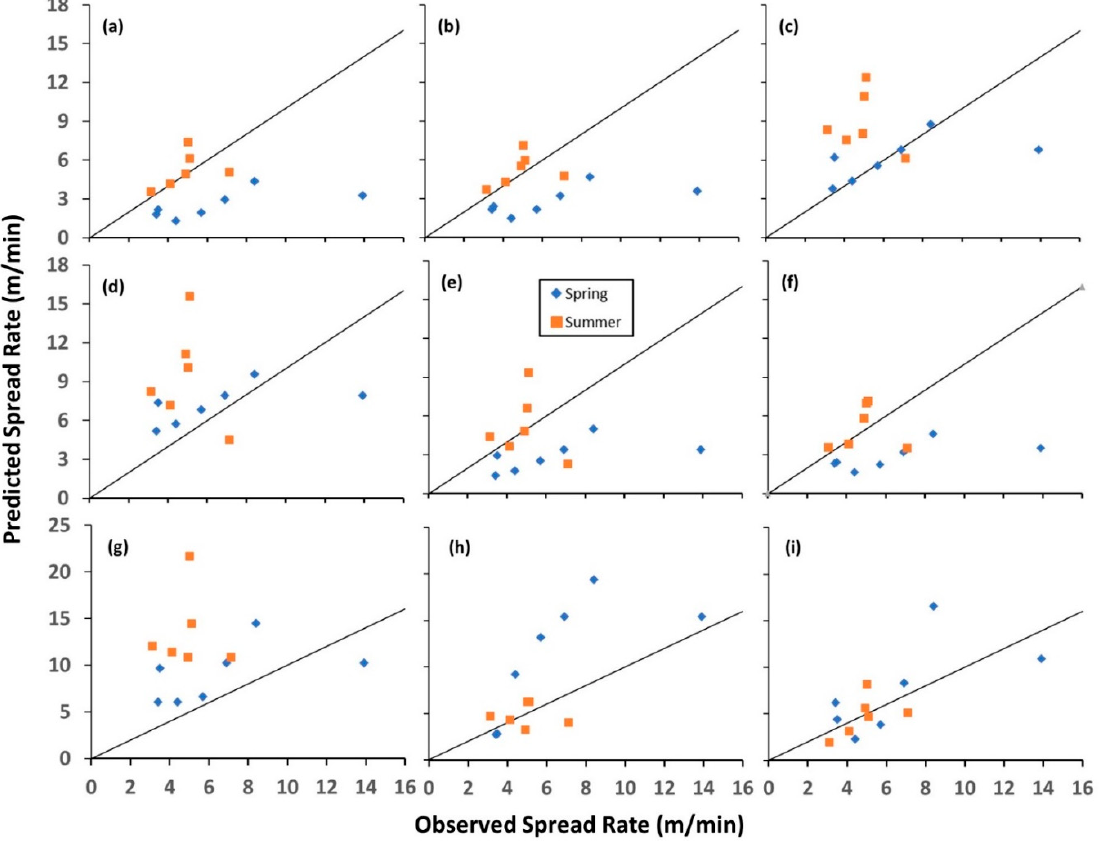
Figure 7. Rate of spread (m / min) for Paquette lake burning conditions using existing shrubland fire behaviour models: ( a ) Anderson et al.’s 2015 height model [5], ( b ) Anderson et al.’s 2015 bulk density model [5], ( c ) Catchpole et al. 1998 [18], ( d ) Davies et al. 2009 [2], ( e ) Fernandes 2000 [3], ( f ) Fernandes 2001 [4], ( g ) US Behave (SH-6) [13]; ( h ) FBP (O-1b) [14]; ( i ) FBP (O-1b modified) similar to [15]. Table 3. Comparison of results from Paquette lake with existing shrubland fire spread rate